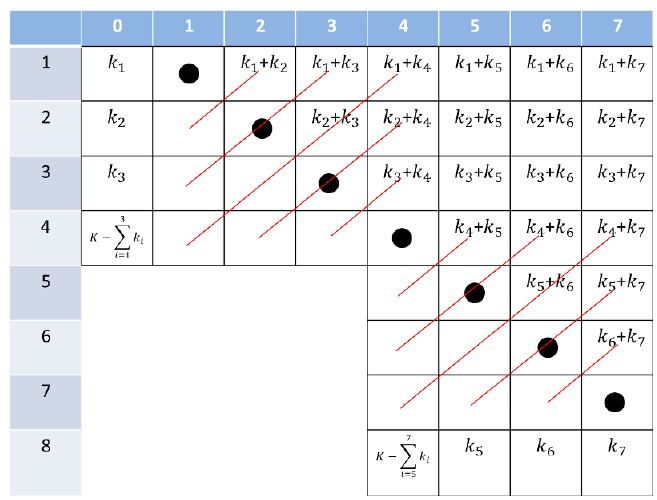
Figure 6 . This (cid:12)gure shows the number of intercating modes from every hypermultiplet in the case described in 4.1. Every pair of scalars q ab ; q ba give rise to k a + k b o(cid:11)-diagonal modes. Their boxes are connected by red lines and the number of modes is written only in one of the boxes. The size modes appear in the boxes without red line on